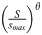
Cumulative distribution of (Ssmax)θ in each network when θ = 1.5.